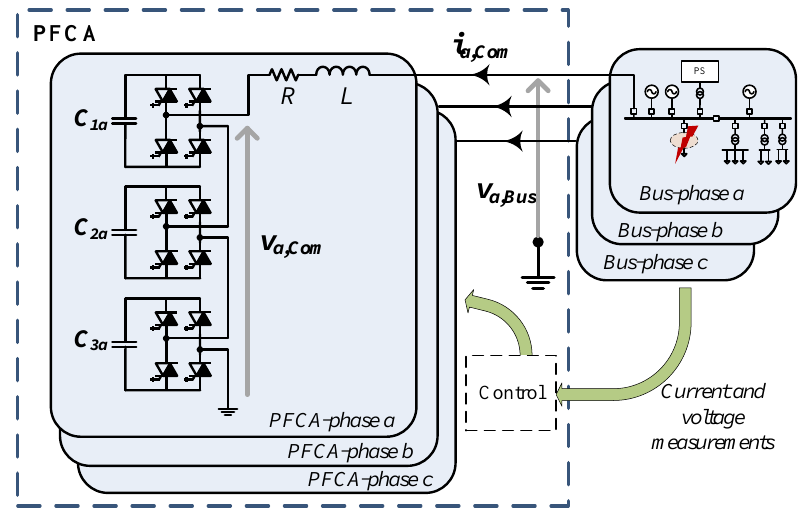
Figure 9. PFCA implemented for the analyzed grid.